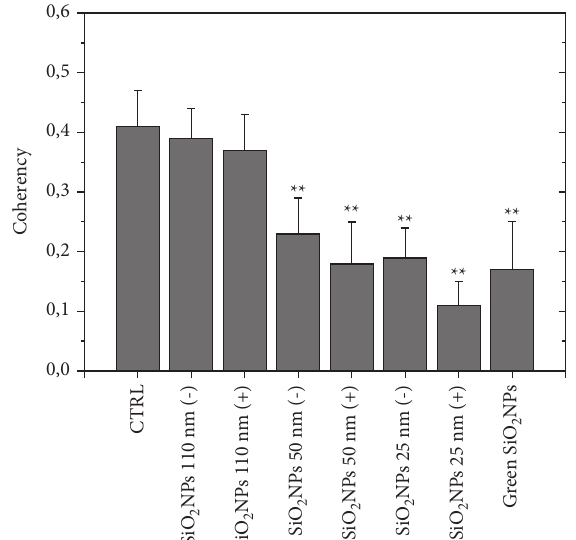
Figure 12: Coherency values calculated on A549 confocal acquisitions. Data were expressed as the mean value and relative SD using ImageJ (calculation on 15 cells). The mean values and their standard deviations are reported in the histograms. Data were statistically significant for ∗∗ p < 0 . 001.